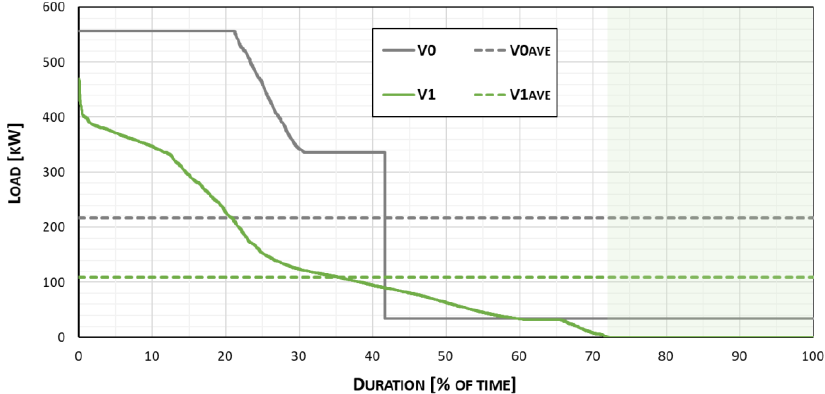
Figure 9. Comparison of the electricity LDCs for the Smulsko cluster.